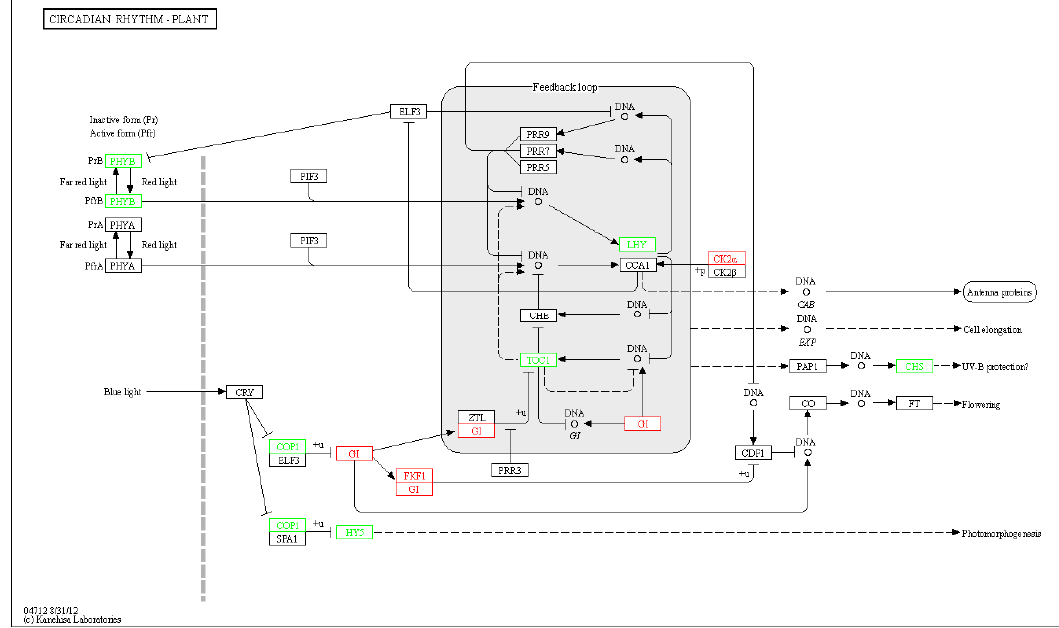
Figure 10. Influences of the plant circadian rhythm pathway under WL vs. RL in C. oleifera leaves. The red color represents up-regulated unigenes and the green color represents down-regulated unigenes.